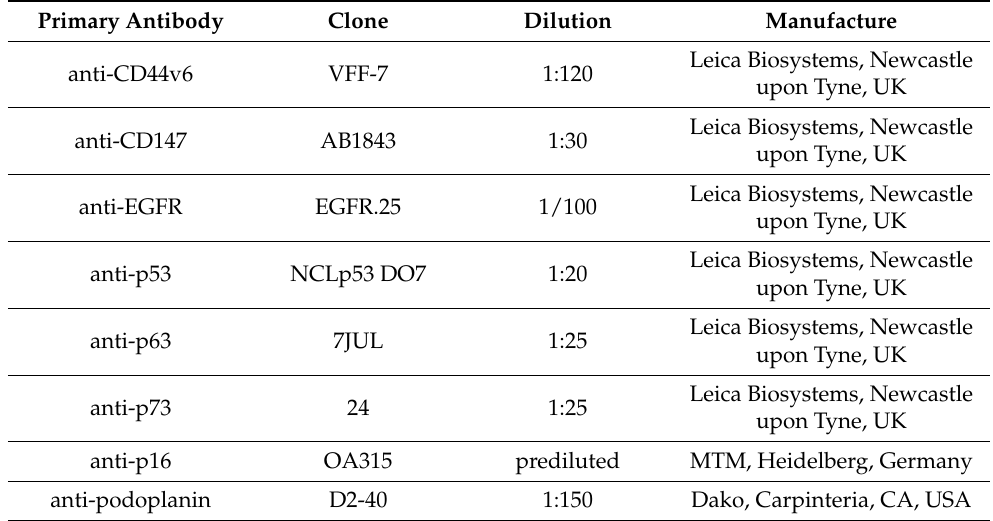
Table 1. Primary monoclonal antibodies used for immunohistochemistry in the study. Primary Antibody Clone